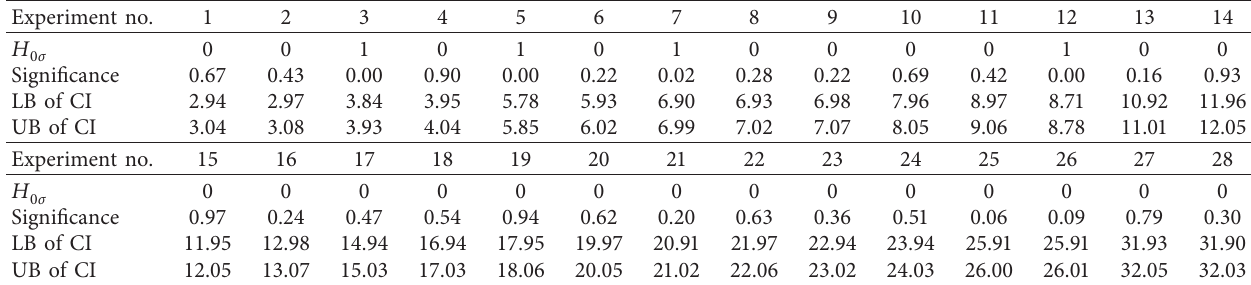
Table 2: Significances and 0.95 confidence intervals for validation